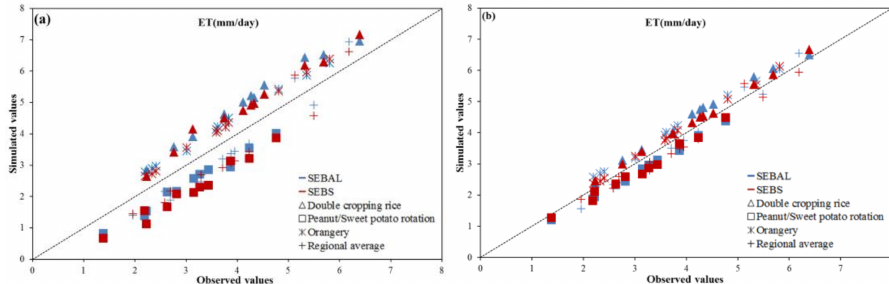
Figure 7. Comparison of simulated ET with the observed values: ( a ) The result of the original model; ( b ) the improved simulation